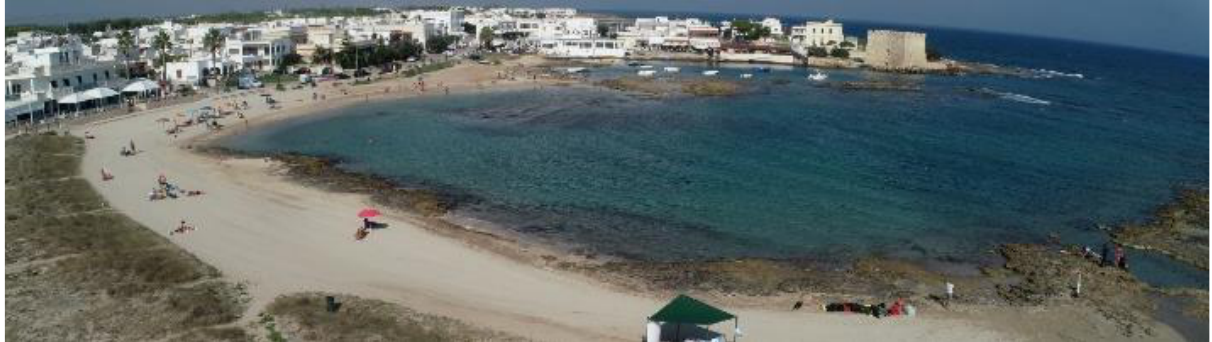
Figure 1 . Panoramic view of the coastline of Baia dei Camerini, Torre Santa Sabina (Carovigno, Brindisi, IT).